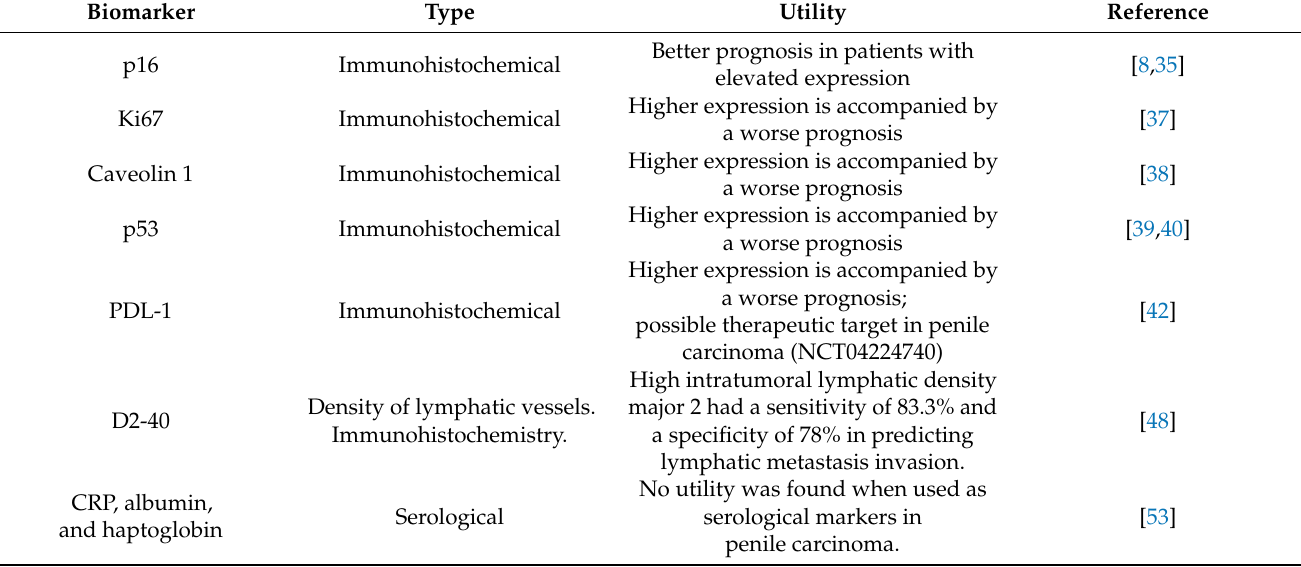
Table 1. Main markers involved and their